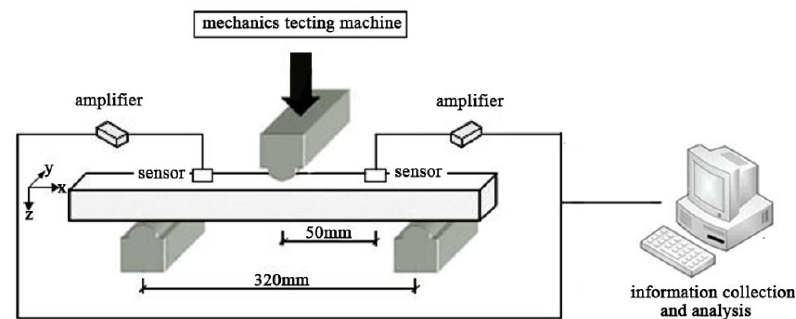
Figure 1. Schematic of the three-point bending test and the acoustic emission signal acquisition.